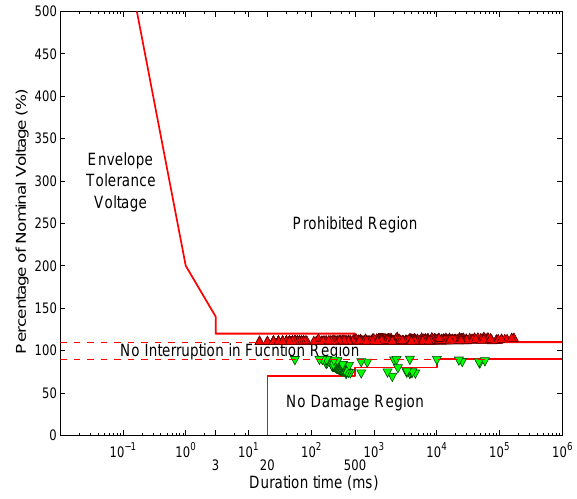
Figure 7. Information Technology Industrial Council (ITIC) curve for dips and swells voltage values before the grid strengthening during one day. Swells are marked with red upwards ‐ pointing triangles and dips are marked with green downwards ‐ pointing triangles.